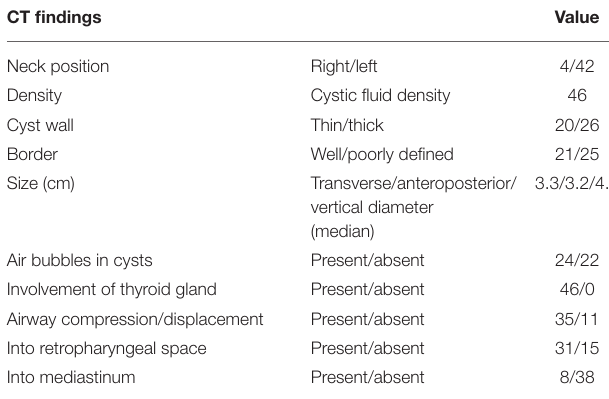
TABLE 2 | CT findings of 46 lesions of